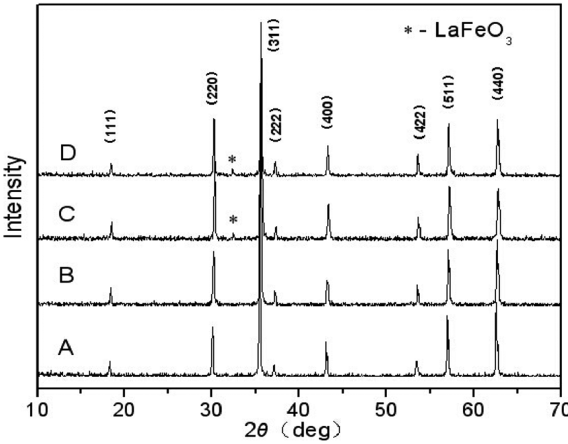
Figure 1: XRD patterns for the